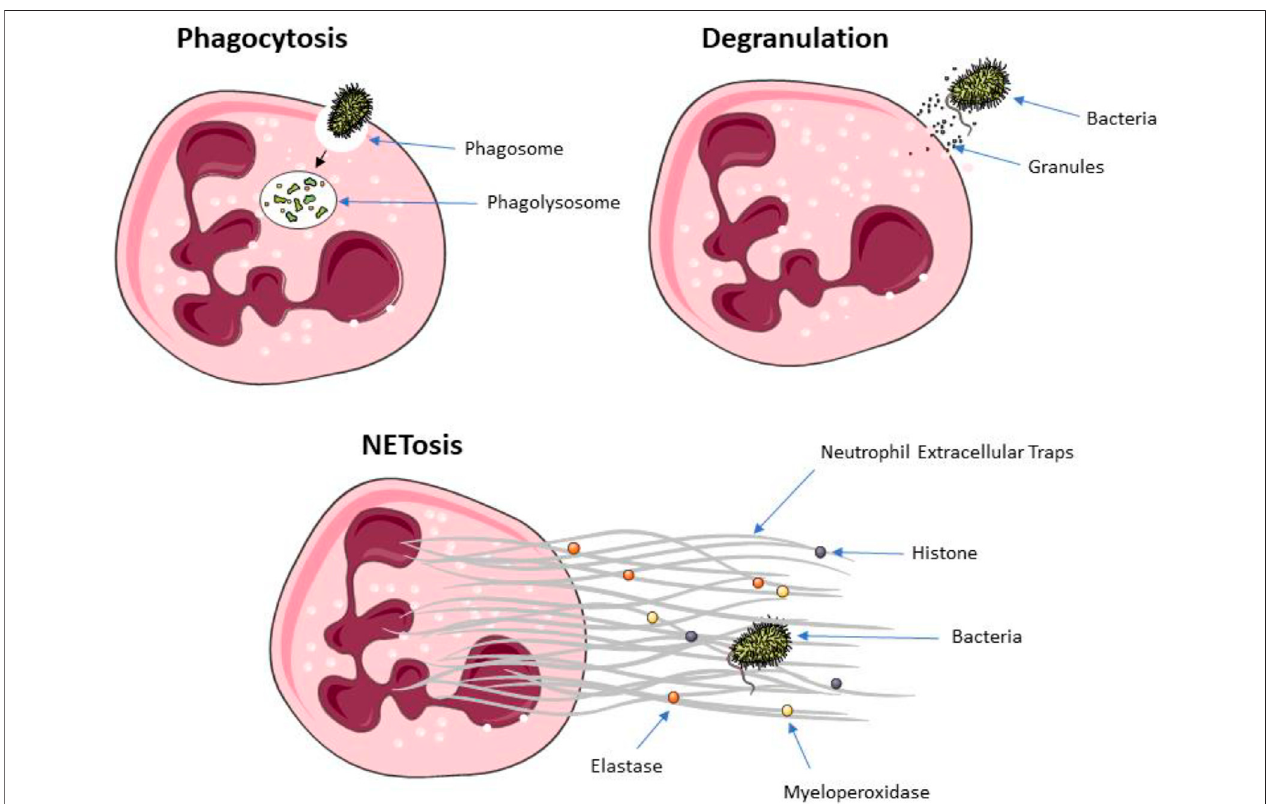
FIGURE 2 | The killing mechanisms of neutrophils: phagocytosis, degranulation, and extracellular traps release.